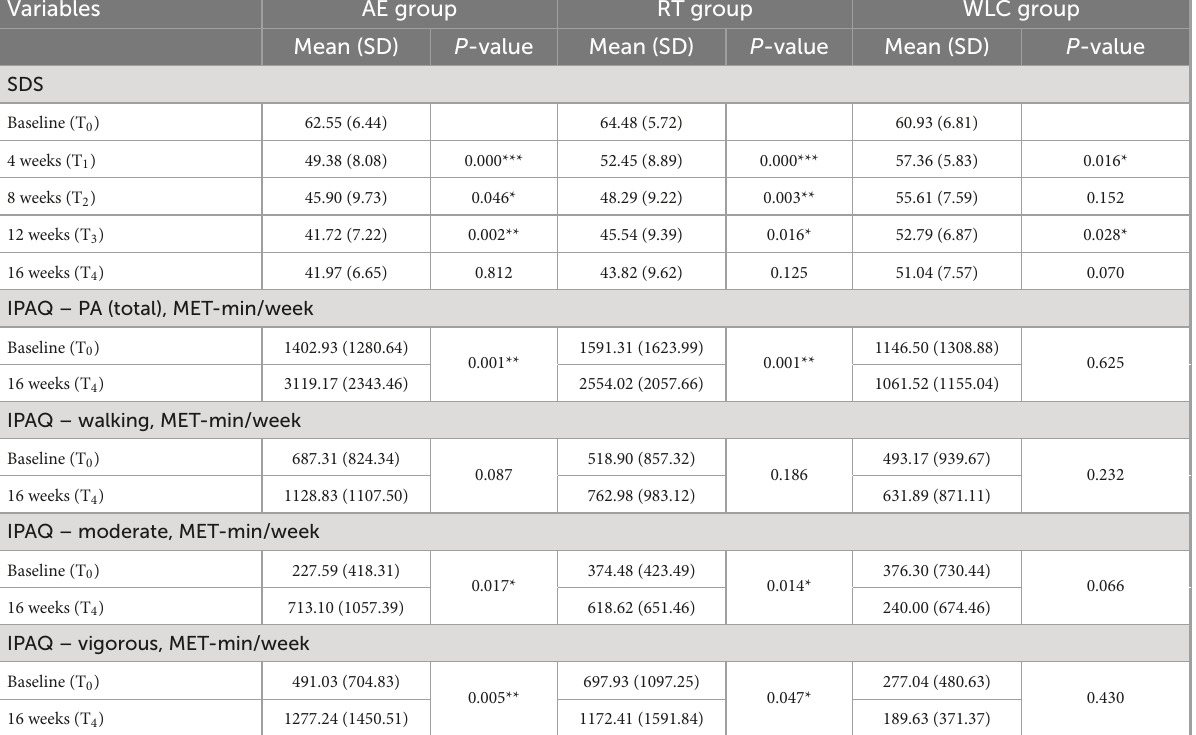
TABLE 5 Comparison of within-group changes in outcomes variables (continuous) for AE, RT, and WLC groups.